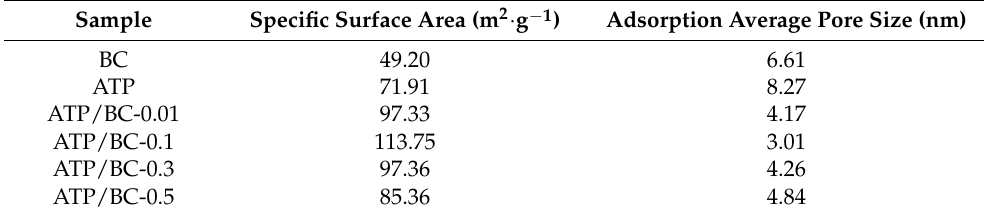
Table 1. The specific surface area and pore size of different